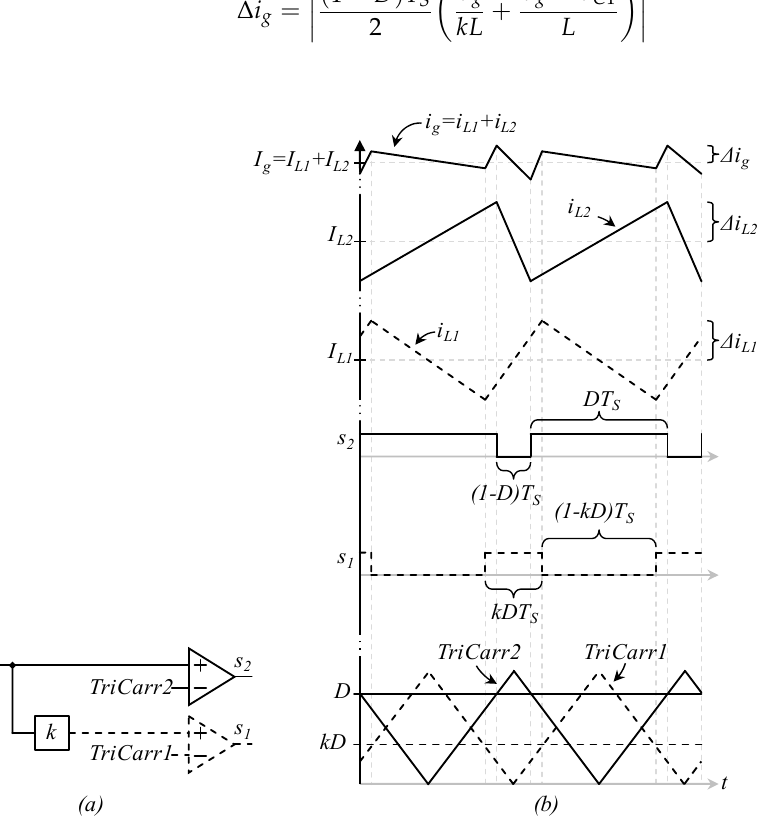
Figure 9. PWM scheme for the proportional strategy ( a ) schematic diagram, ( b ) Important signals. Notice that (30) already considers L 2 = L and L 1 = kL